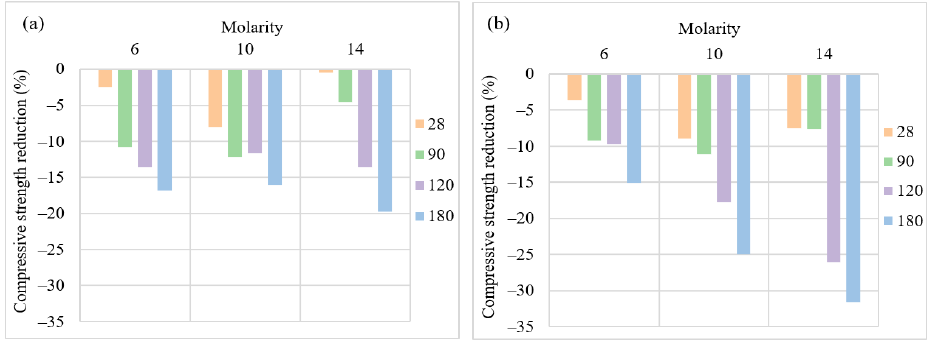
Figure 6. The effects of NO/NS ratio of compressive strength reduction after acid exposure ( a ) NO/NS = 1 and ( b ) NO/NS = 3.